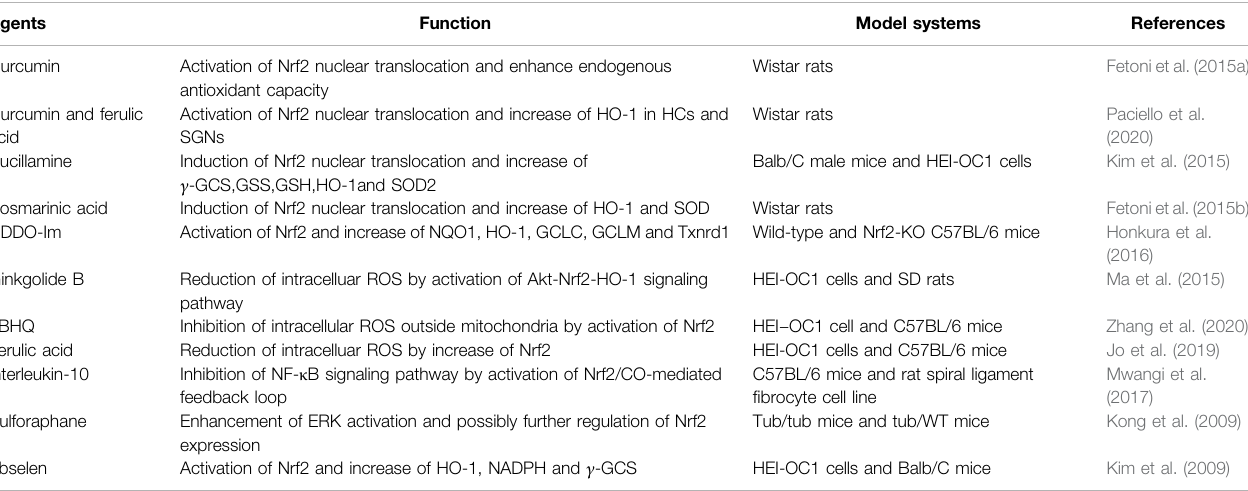
TABLE 2 | Drugs acting on Nrf2 for hearing protection in vitro studies.